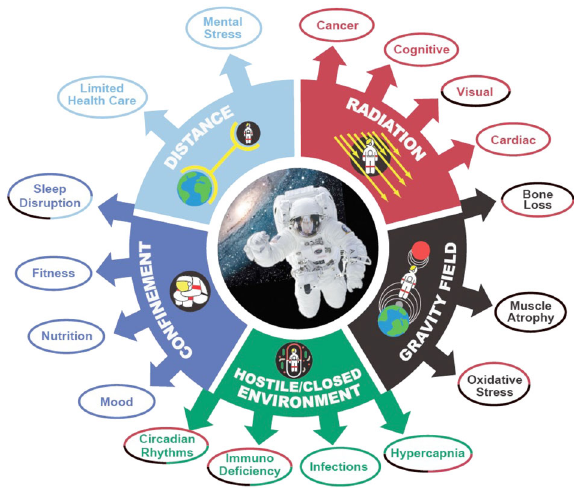
Fig. 1 Physical and biological factors affecting human space exploration and their associated stressors including isolation, long con fi nement in closed environments, microgravity, and ionizing radiation. These factors are likely to act both alone and in combination to impose effects on the crew in